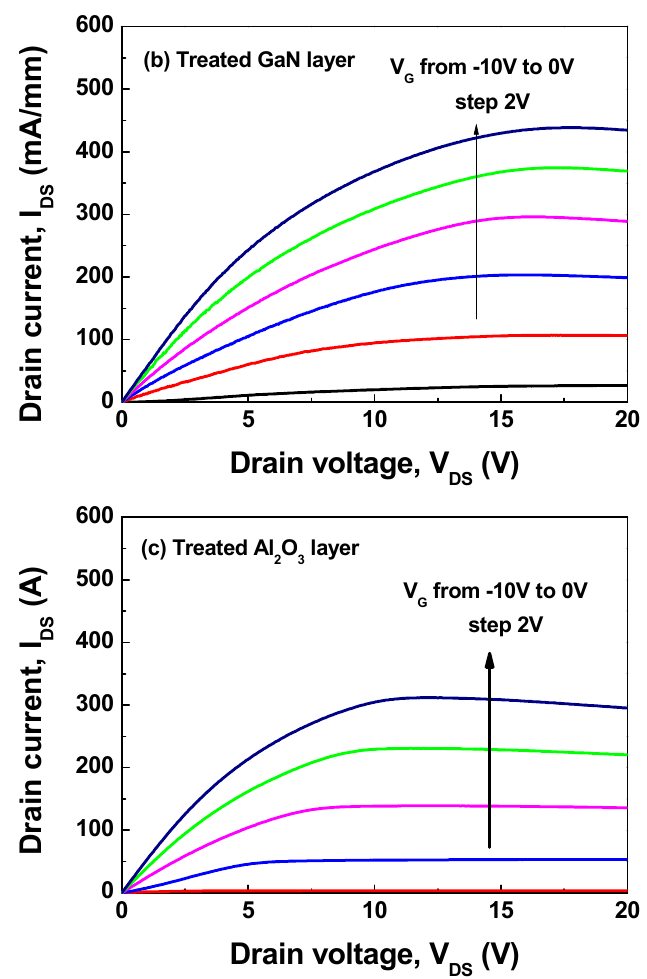
Figure 3. I DS –V DS output characteristics of the MOS-HEMT: ( a ) untreated; ( b ) with a treated GaN; and ( c ) with a treated Al 2 O 3 layer. Table 1. Comparison of the characteristics of the semiconductor before and after the corona discharge plasma treatment.